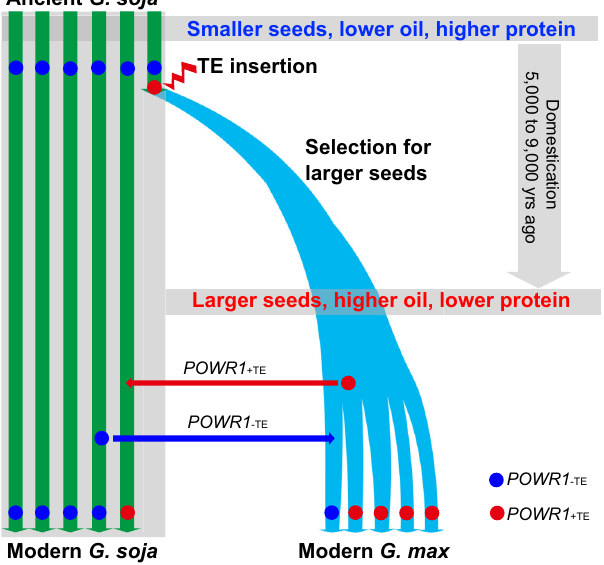
Fig. 6 A proposed model of POWR1 as a player in soybean domestication. The insertion of a LINE transposon represents an important event in the transition from G. soja to G. max during soybean domestication. Following the TE insertion, the progeny from plants containing POWR1 + TE expands due to selection for bigger seeds by ancient farmers. Selection for larger seeds results in complete fi xation of POWR1 + TE in all G. max accessions, which contributes to shaping cultivated soybean with increased oil but reduced protein content in seeds in comparison with G. soja accessions due to the pleiotropy of POWR1 on the seed traits. Transfer of POWR1 alleles between G. max and G. soja also occurs after domestication, which result in the G. max accessions containing POWR1 − TE and one G. soja accessions containing POWR1 + TE . The transfer of POWR1 − TE of G. soja to G. max is likely driven by local needs for high-protein soybeans in East Asia. The one G. soja accession with TE insertion likely originated from a hybridization event between G. max and G. soja as previously reported for semi-wild soybean genotypes 41